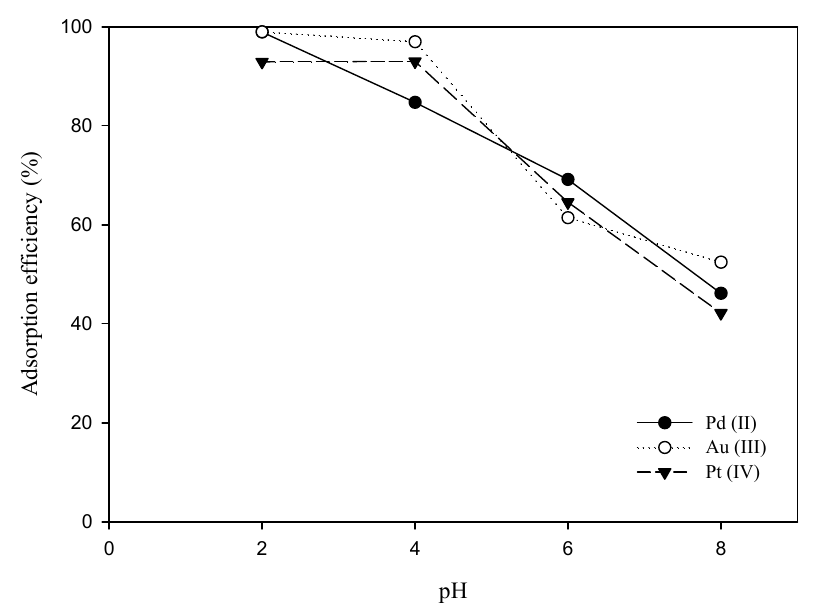
Figure 3. Effects of pH on the adsorption of Pt(IV), Au(III) and Pd (II) by